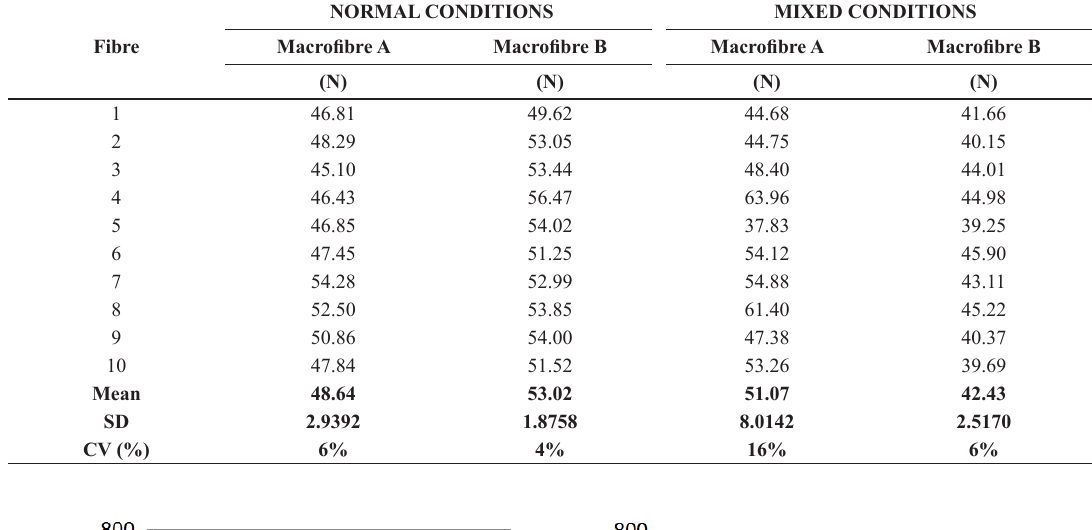
Table 3- Maximum loads of macrofibres in normal and mixed conditions